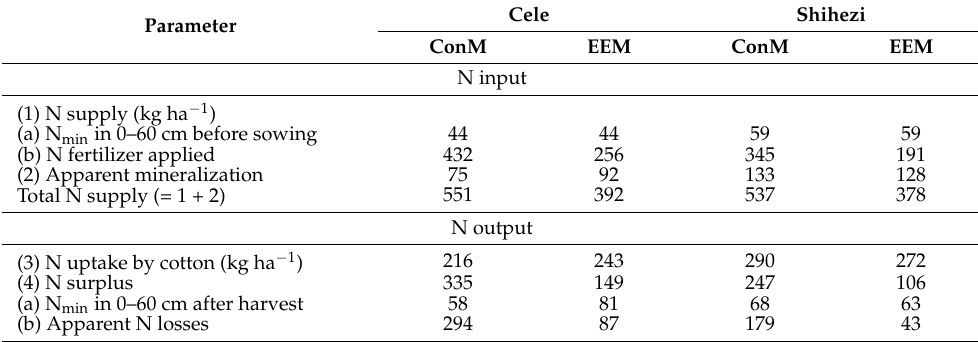
Table 5. Nitrogen balance in cotton under different irrigation and nitrogen